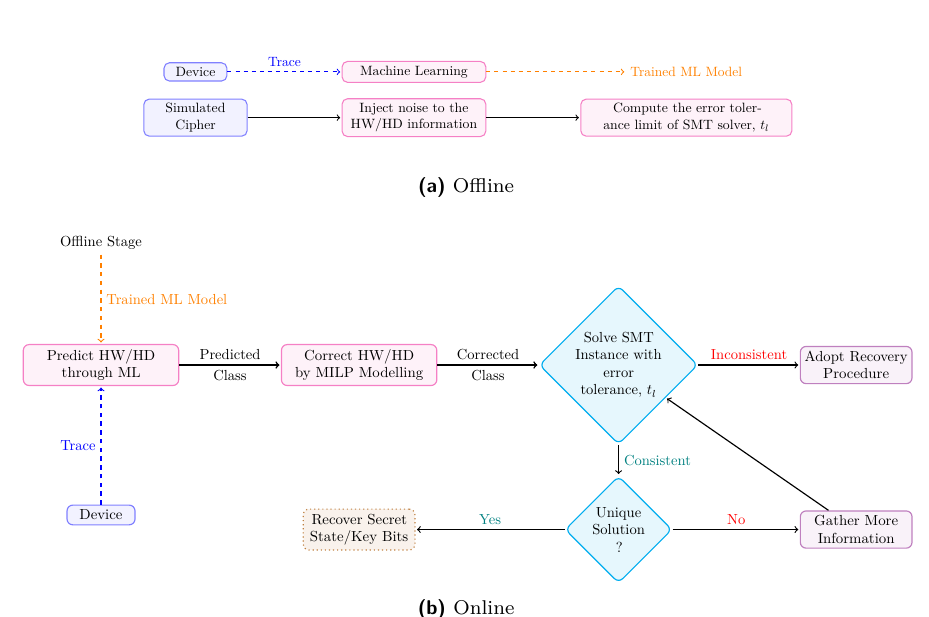
Figure 1: Schematic of work-flow of our side channel attack